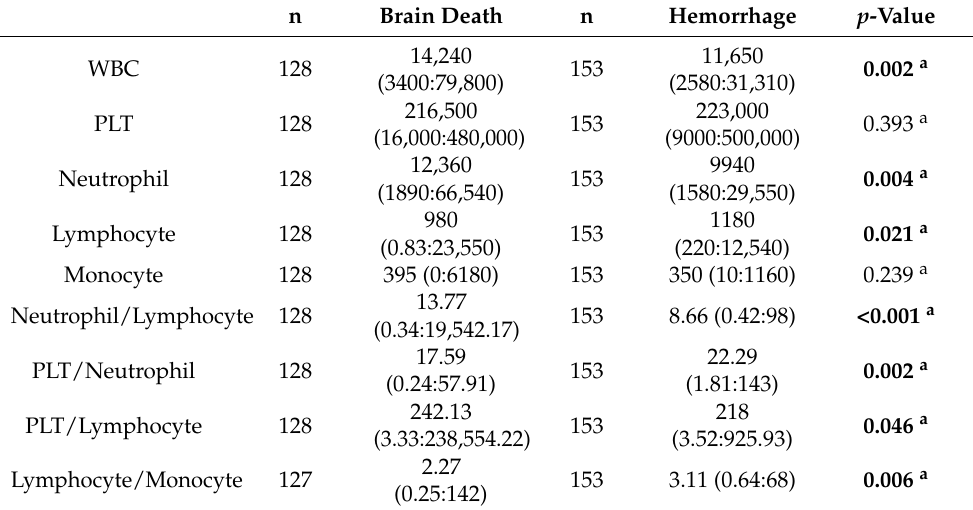
Table 2. Comparison of hematological